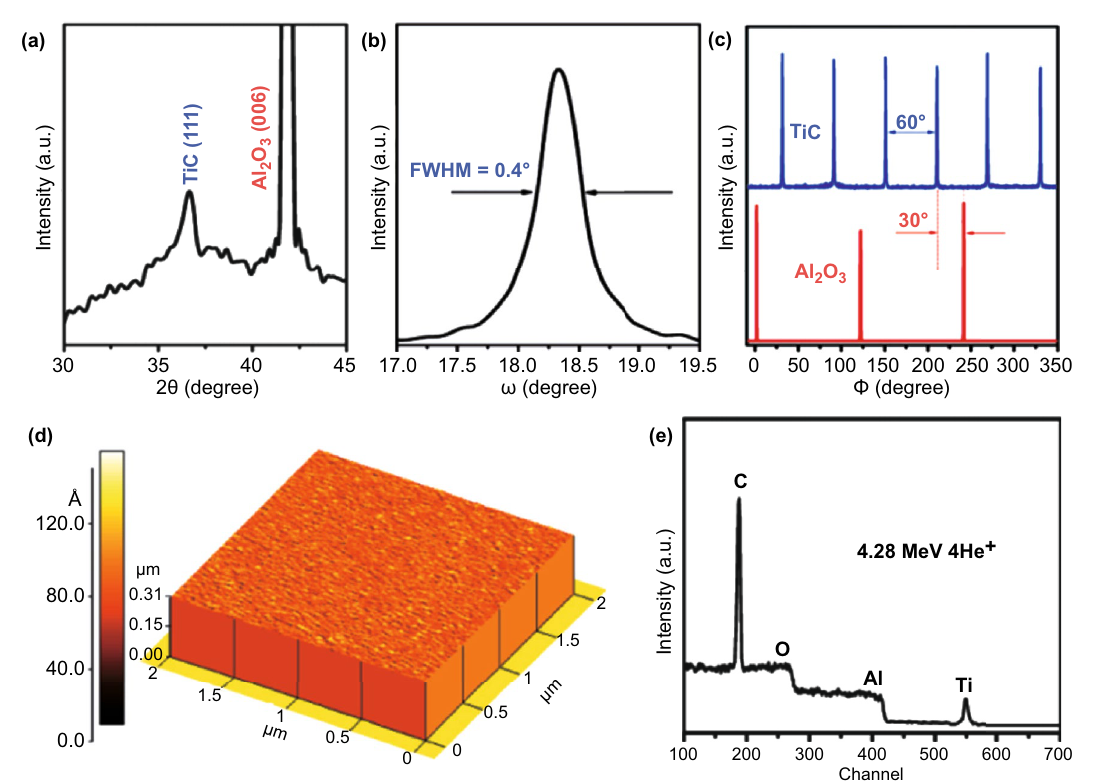
Fig. 8 Preparation of TiC by temperature-programmed reduction. a - c XRD analysis of TiC film. d AFM morphology of TiC film. e Element analysis of TiC film. Reproduced with permission from Ref. [109]. Copyright 2010, American Chemical